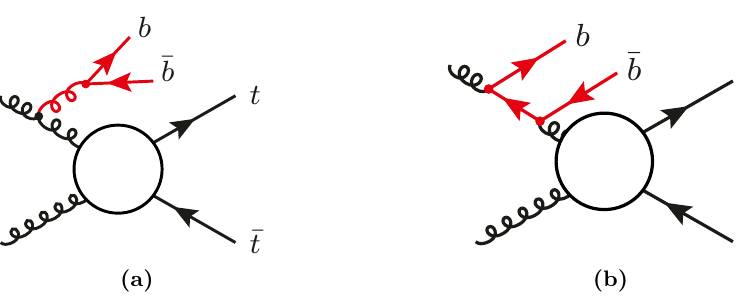
Figure 3. Generic leading-order gg t (cid:22) tb (cid:22) b topologies with (cid:12)nal-state (a) and initial-state (b) ! g b (cid:22) b splittings. The bulk of the t (cid:22) tb (cid:22) b cross section is dominated by topologies of type (a) with ! rather collinear splittings, while initial-state collinear splittings become important in the region of large (cid:1) R bb